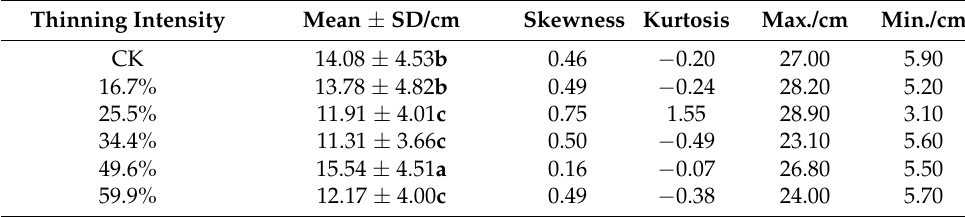
Table 3. Distribution parameters of tree DBH. Thinning Intensity Mean ± SD/cm